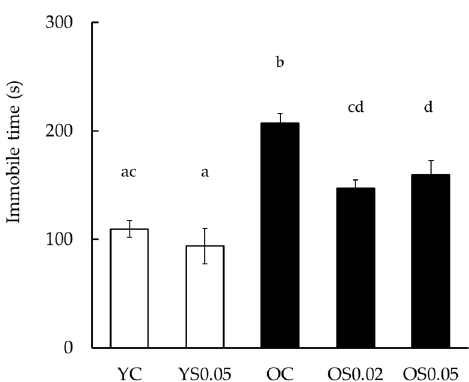
Figure 3. The effects of sesame lignans on a forced swim test in young and old mice. Values are the mean ± SEM. Statistical analyses were performed using a one-way ANOVA followed by a Tukey–Kramer post hoc analysis. Different letters indicate significant differences ( p < 0.05). Experimental groups are indicated as: Young control, fed basal diet (YC, n = 8), young, fed basal diet supplemented with 0.05% sesame lignans (YS0.05, n = 7), old control, fed basal diet (OC, n = 9), old, fed basal diet supplemented with 0.02% sesame lignans (OS0.02, n = 12), and old, fed diet supplemented with 0.05% sesame lignans (OS0.05, n = 11).